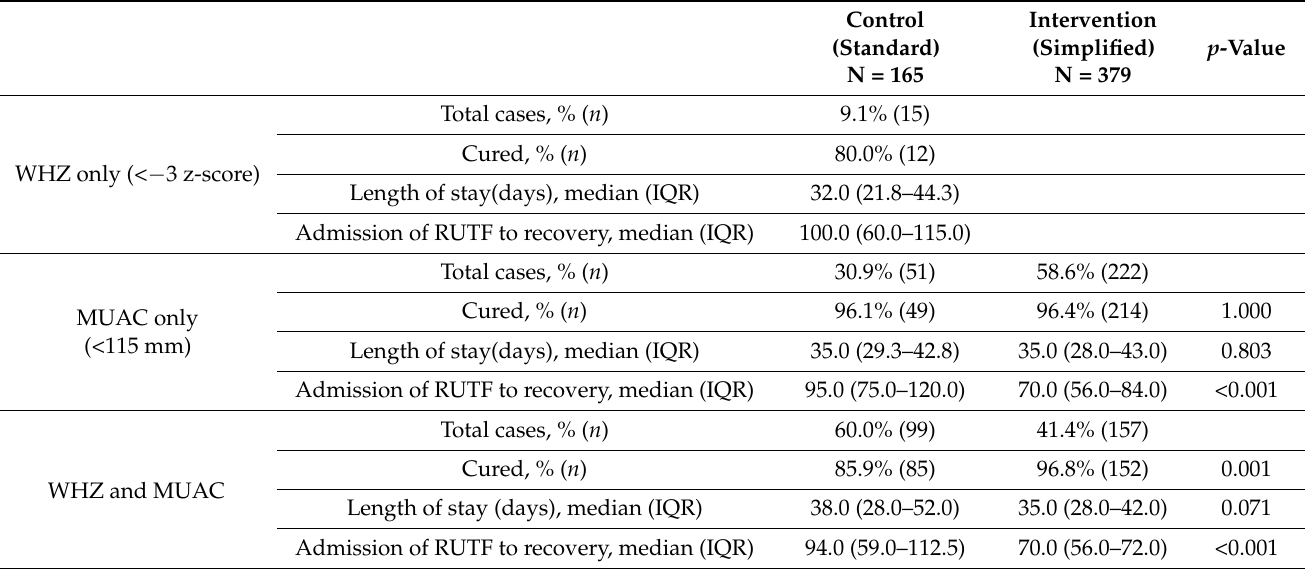
Table 6. Treatment results by anthropometric classification at admission compared by